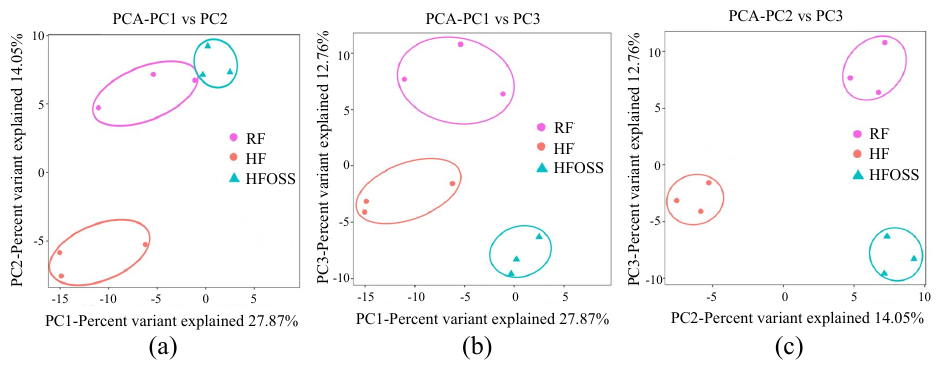
Figure 9. Principle components analysis (PCA) results. ( a ) PC1 vs. PC2, ( b ) PC1 vs. PC3, and ( c ) PC2 vs. PC3. Each point in the figure represents a sample. The distance between points represents the variance of different bacterial communities of the sample. The closer the distance between the points, the higher the similarity between the samples.